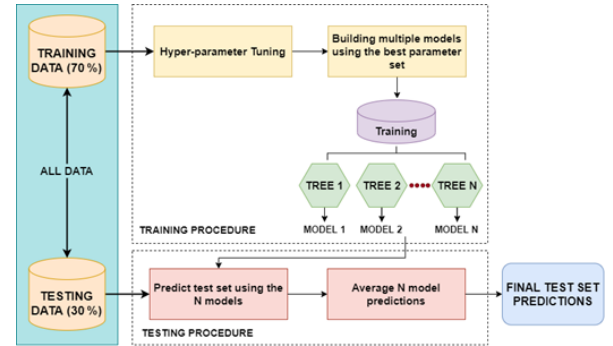
Figure 5. Training and testing procedure of the XGBoost